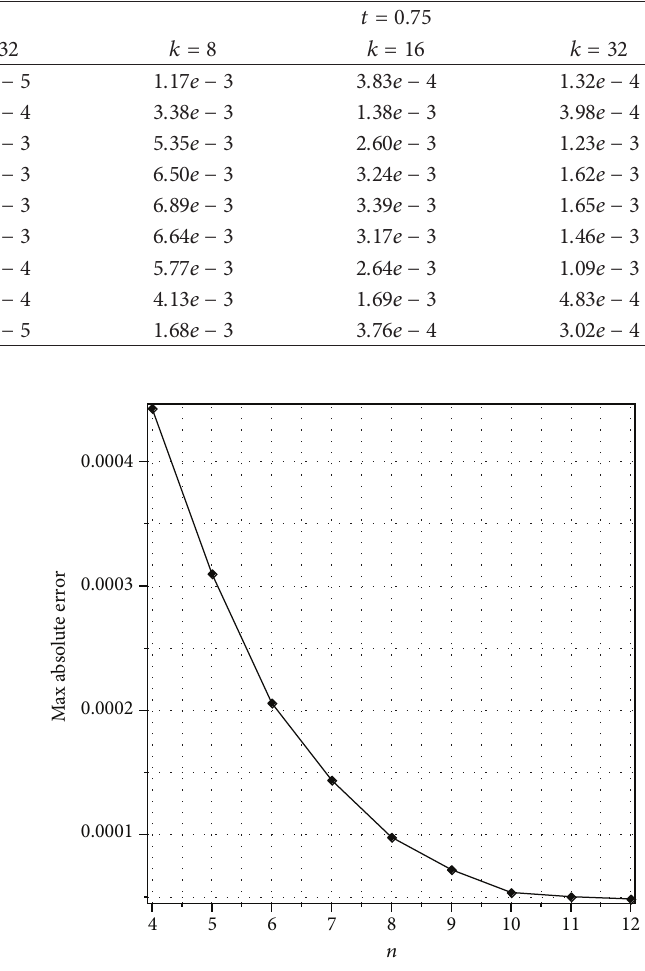
Figure 2: Plot of the maximum absolute errors for different values of 𝑛 with 𝑡 = 0.5 and 𝑘 = 8 for Example